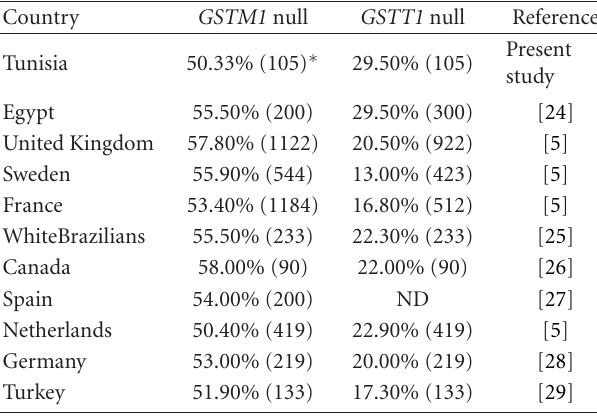
Table 4: Comparison frequencies of GSTM1 and GSTT1 gene poly- morphisms in Caucasian control